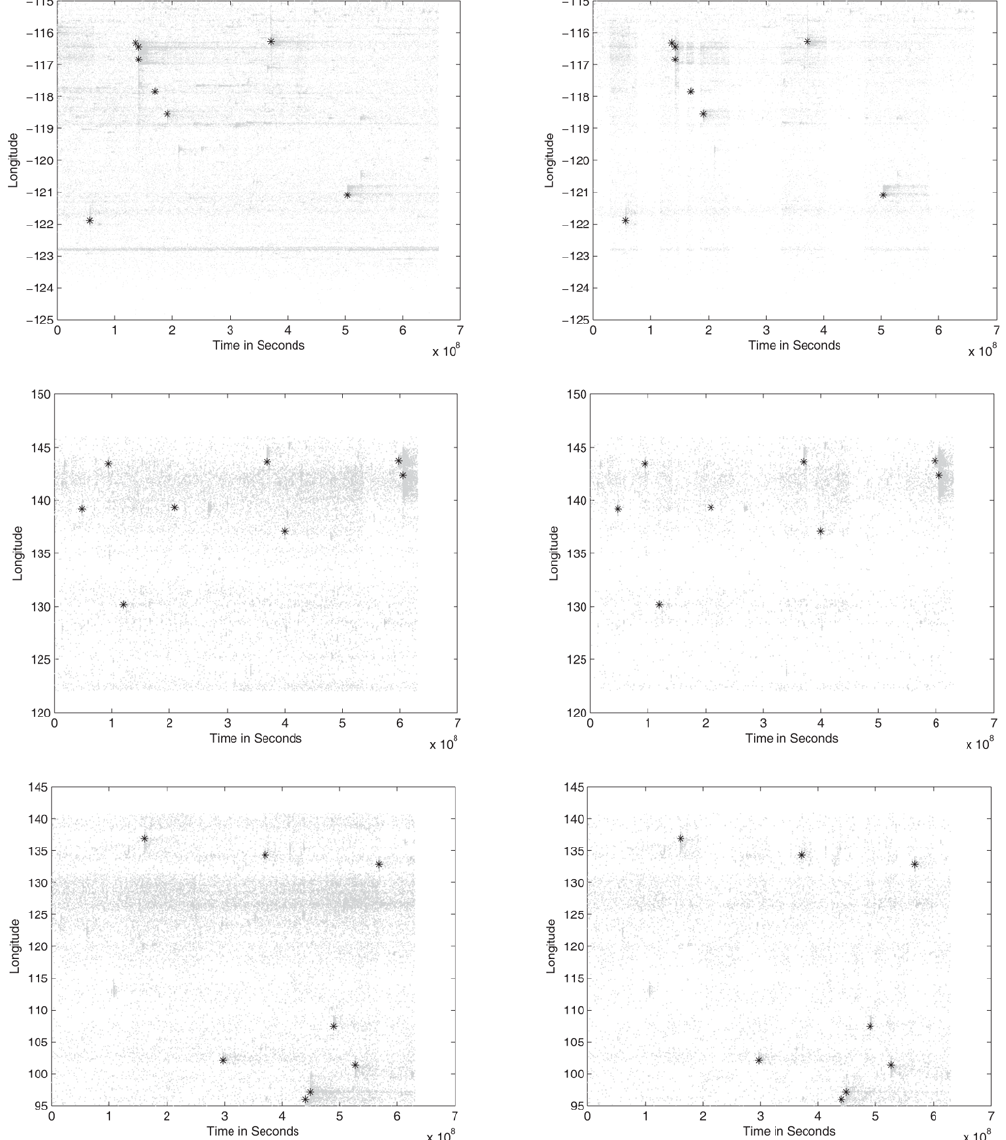
Fig. 12. Plot of longitude vs. time for true and declustered catalogs obtained with the proposed tri-stage cluster identification model: (top left–right) true and declustered catalog plots for California catalog, respectively; (middle left–right) true and declustered catalog plots for Japan catalog, respectively; (bottom left–right) true and declustered catalog plots for Indonesian catalog, respectively. (cid:2) (cid:3) clusters is taken as mean ( Mag ( Category4 )) − 0 . 25 , as four major earthquakes happened in the same year.